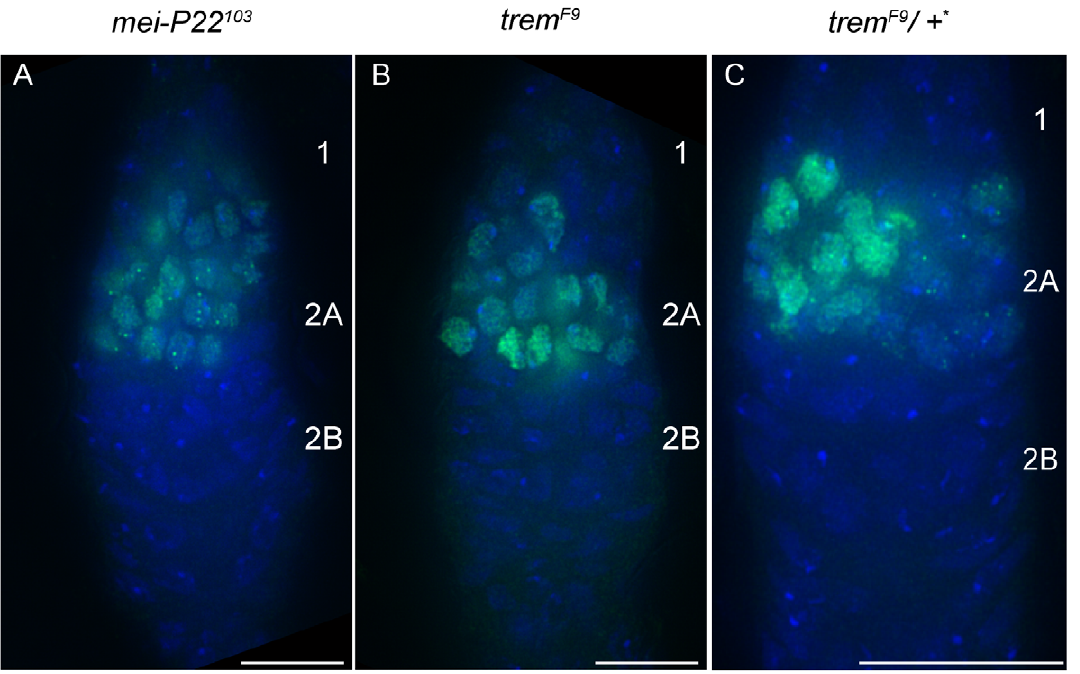
Figure 6. Mei-P22 fails to localize to discrete foci in trem F9 females. Mei-P22 3XHA overexpression in the germline of trem F9 females fails to localize to discrete foci in early pachytene. Maximum intensity projection of deconvolved Z-series through whole mount germarium stained with DAPI and antibodies to HA. (A) Females of the genotype P{nos-Gal4::VP16}/ + ; PUASp-mei-P22 3XHA / + ; mei-P22 103 show both chromatin-associated Mei- P22 3XHA , as well as its localization to discrete foci in 50/50 images. (B) Females of the genotype P{nos-Gal4::VP16}/ + ; PUASp-mei-P22 3XHA / + ; trem F9 only show the chromatin associated localization pattern. No discrete foci were detected in 60 images analyzed. (C) Females of the genotype P{nos- Gal4::VP16}/ + ; PUASp-mei-P22 3XHA / + ; trem F9 /TM3, Sb show both chromatin-associated Mei-P22 3XHA , as well as its localization to discrete foci in 8/8 images. ( + * ) chromosome is the 3 rd chromosome balancer chromosome, TM3 Sb , and the females used were the sisters of the P{nos-Gal4::VP16}/ + ; PUASp-mei-P22 3XHA / + ; trem F9 females in B. Germarium regions 1, 2A and 2B are shown in (A–C). Scale bars, 10 m m (A–B) and 15 m m (C).